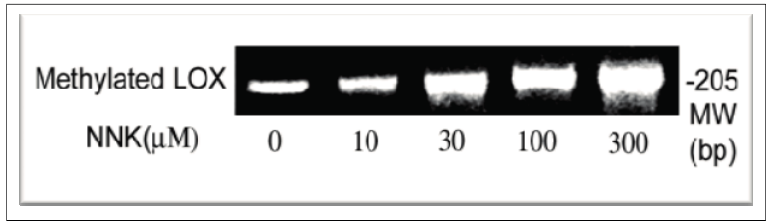
Figure 7. Enhancement of methylation at the LOX promoter region in NNK-treated cells as determined by using the methylation promoter PCR kit. The same amount of genomic DNA isolated from control and NNK-treated cells were digested with restriction enzyme Mse I, then incubated with MBP to form a protein/DNA complex. Methylated DNA was isolated using a separation column and amplified by PCR. PCR products as a 205 bp DNA were analyzed on 2.2% agarose gels and densities of DNA bands measured by the 1D